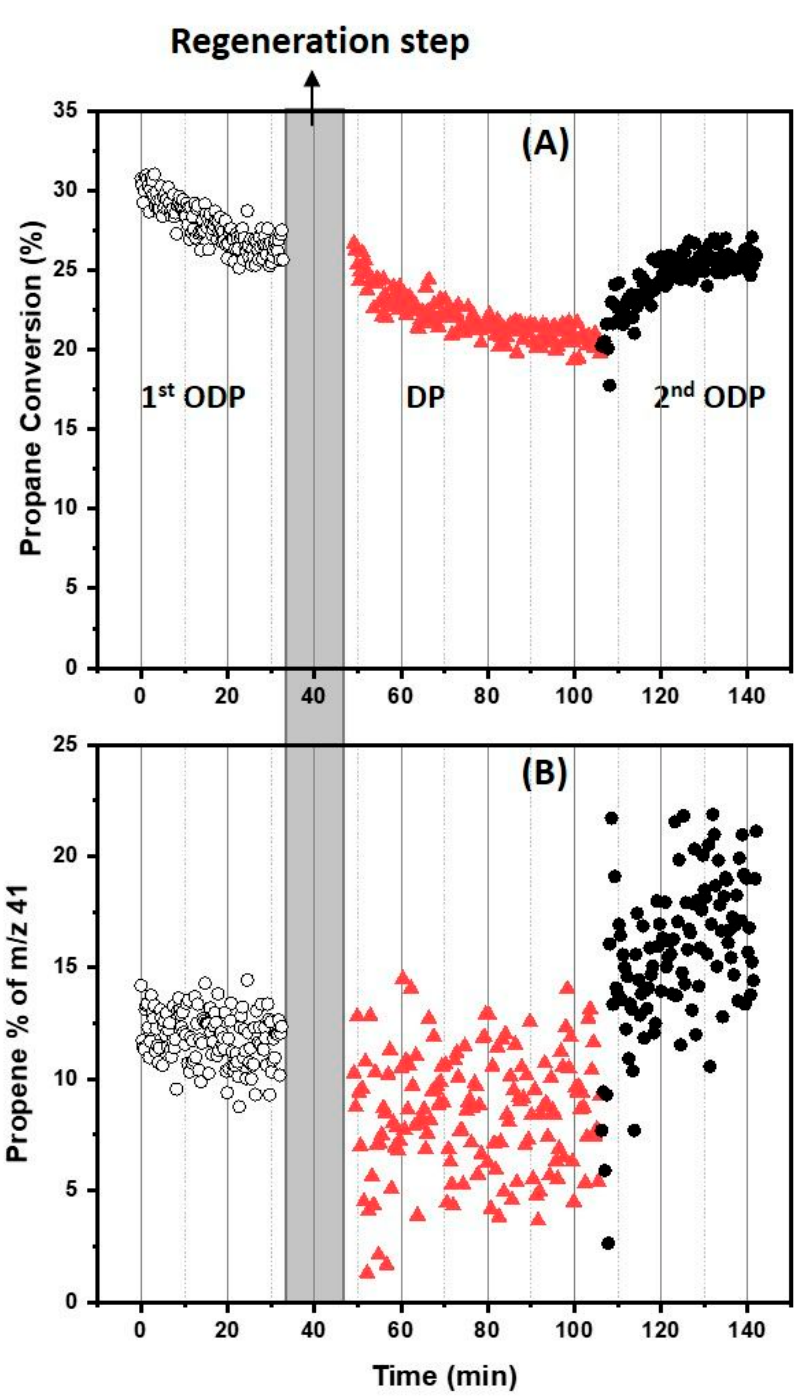
Figure 1. The subsequent oxidative and non-oxidative dehydrogenation of propane activity over MoO x / Al 2 O 3 at 500 ◦ C shown as ( A ) Propane conversion and ( B ) Propene formation. Propene formation is presented as the contribution of propene to the mass spectrometry response of m / z 41 expressed as a%. This is calculated by subtracting the contribution of propane to m / z 41. Refer to the Materials and Methods section for activity test